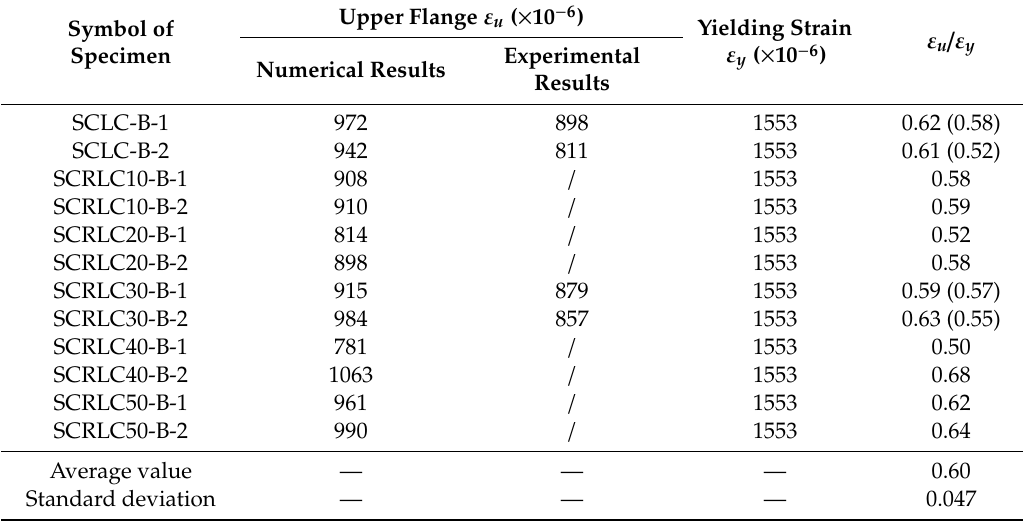
Table 11. Strain of profiled steel sheet.